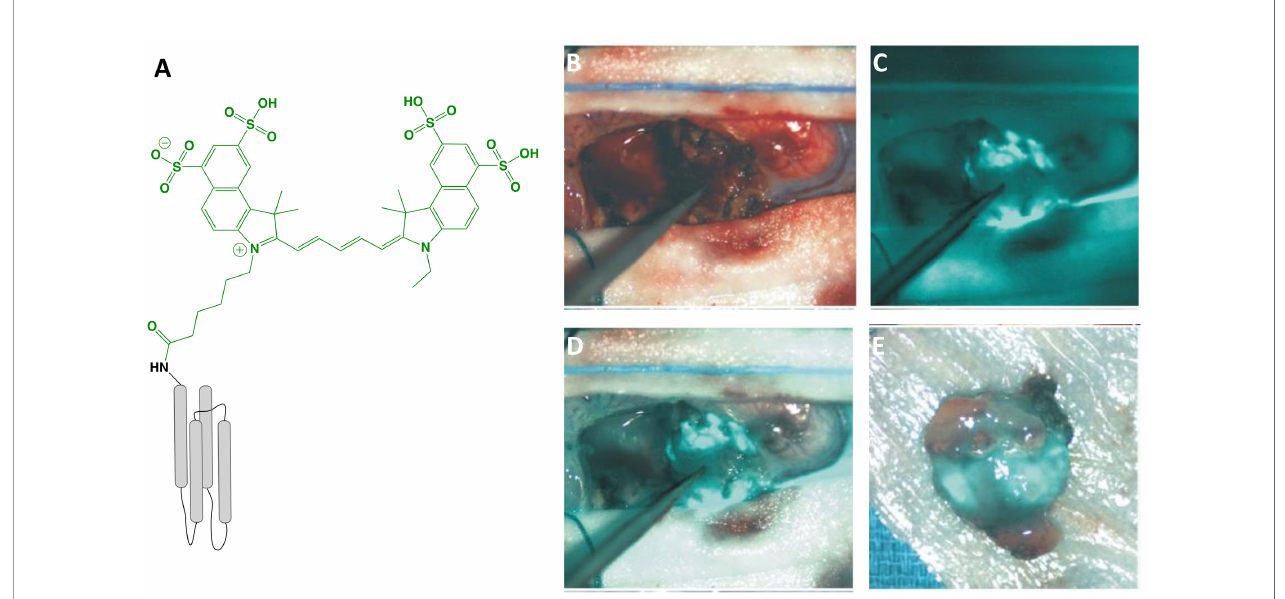
FIGURE 2 | BLZ-100 (Tozuleristide, Tumor Paint ™ ). Schematic* of the peptide CTX (targeting motif; gray) labeled with Cy5.5 (dye; green) (A) . Intraoperative glioblastoma imaging with 18 mg total BLZ-100 administered 4 h prior to surgery: white-light only (B) , NIRF only (C) and white-light with NIRF overlay (D) . Ex vivo imaging, white-light with NIRF overlay (E) . Panels (B – E) are adapted from (48) with permission. *Not to